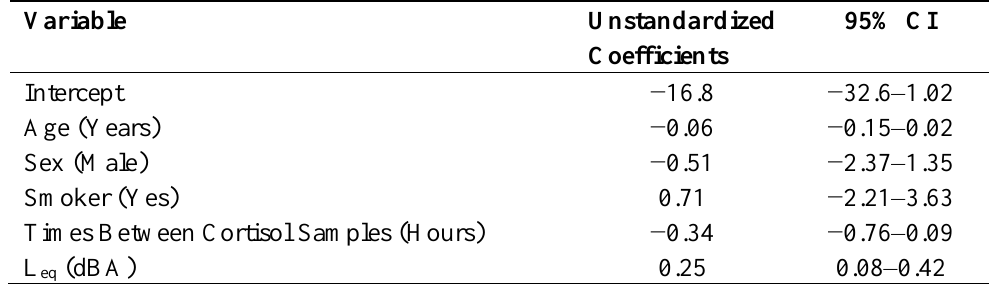
Table 3. Linear regression model of changes in cortisol level